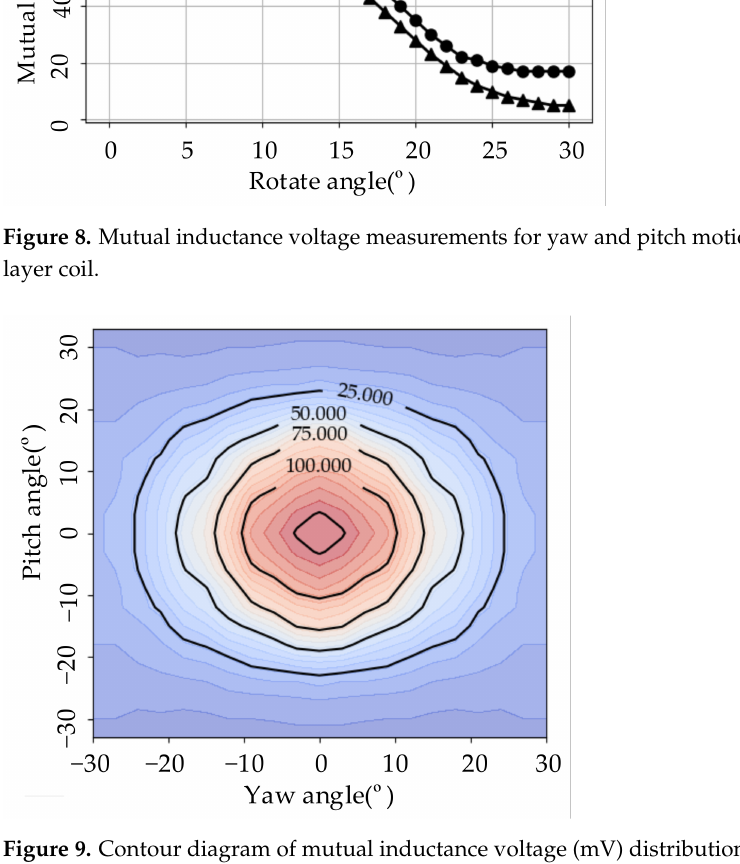
Figure 9. Contour diagram of mutual inductance voltage (mV)